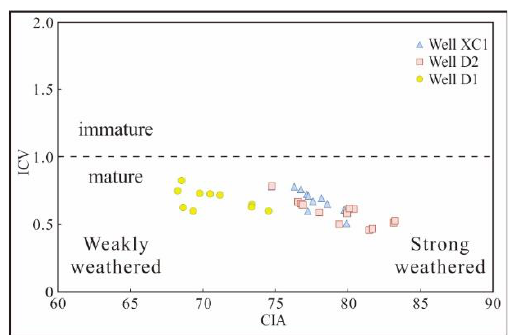
Figure 8. ICV − CIA plot for the J 2 z 1 Formation of Wudun sag.